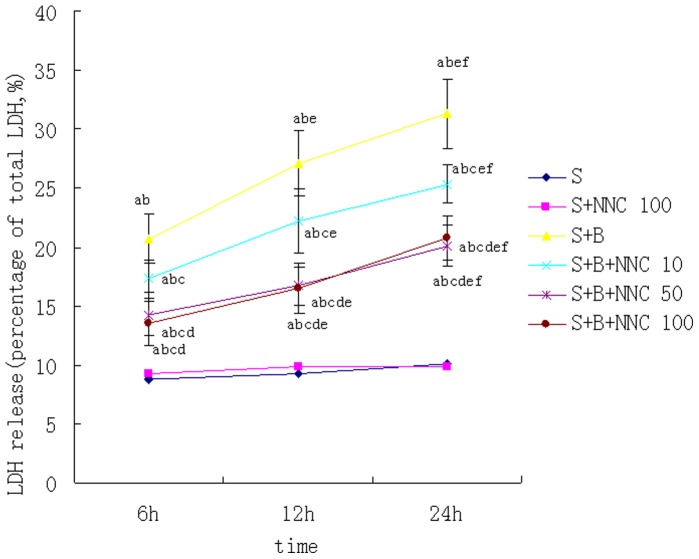
Bupivacaine treatment leads to the release of LDH.SH-SY5Y cells were either pretreated with the indicated concentrations of NNC 55-0396 dihydrochloride or left untreated prior to 1 mM bupivaine treatment for 24 h. LDH release was determined by the level of LDH activity present in the culture media. (%, mean±S.D, n = 6). aP<0.05 vs. S group; bP<0.05 vs. S+NNC100 group; cP<0.05 vs. S+B group; dP<0.05 vs. S+B+NNC 10 group; eP<0.05 vs. time point of 6 h; fP<0.05 vs. time point of 12 h.